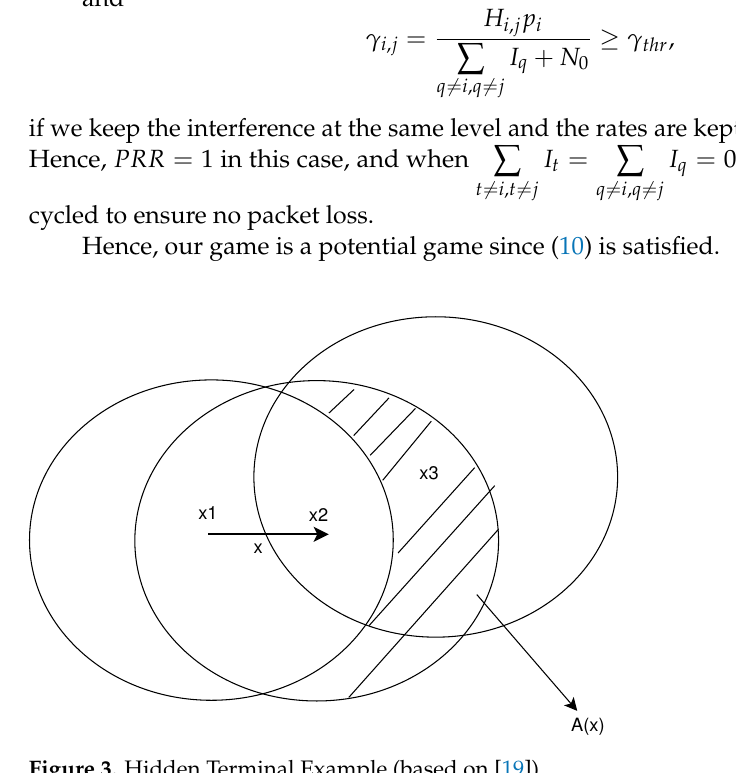
Figure 3. Hidden Terminal Example (based on